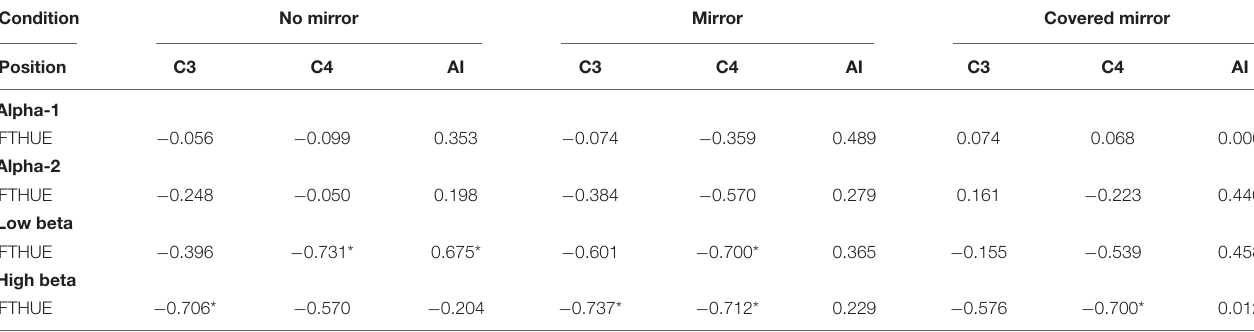
TABLE 3 | Correlation between levels of arm severity with ERSP power in three task conditions in patients with stroke. Condition No mirror Mirror Covered mirror Position C3 C4